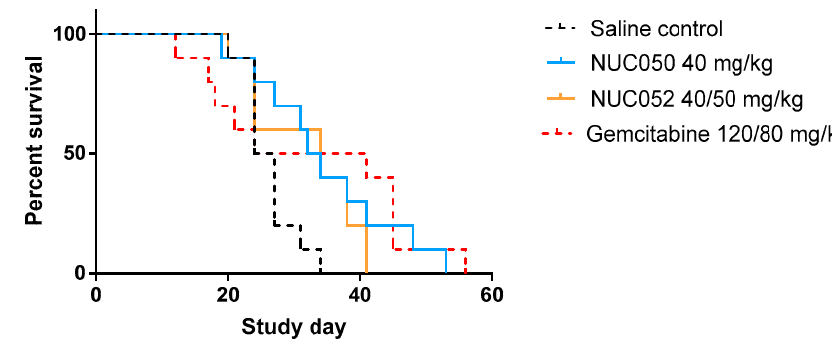
Figure 3. Survival proportions of NUC050, NUC052 and gemcitabine vs. saline control (SC) ( n = 10 per group) in mice with human NSCLC NCI-H460 tumor implants. “Survival” refers to animals that were not removed from the study by death or per protocol euthanasia. Mice were administered the dose indicated IV qwk × 4 (study days 4–25) for NUC050. NUC052 was administered at 40 mg/kg IV qwk × 2 then 50 mg/kg IV × 2 (study days 4–25). Gemcitabine was administered IP at 120 mg/kg q3d × 4 and then 80 mg/kg IP q3d × 5 (study days 4–28). Median survival SC = 25.5 days. (1) NUC050 median survival = 33 days, hazard ratio (HR) vs. SC = 0.24 ( p = 0.017, Log rank test). (2) NUC052 median survival = 34 days, HR = 0.27 ( p = 0.033, Log rank test). (3) Gemcitabine median survival = 32.5 days, HR = 0.46 ( p = 0.18, Log rank test).